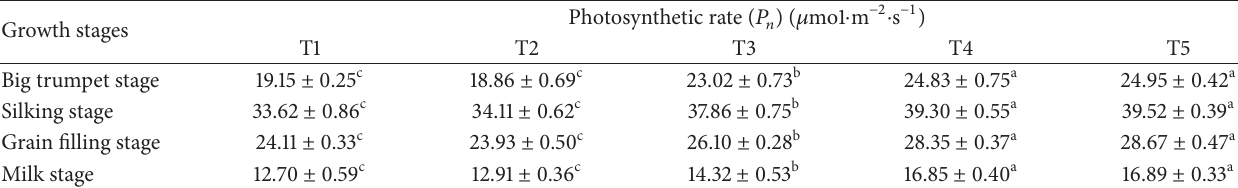
Table 2: Effects of Si application on net photosynthetic rate ( 𝑃 𝑛 ) in leaves of maize.